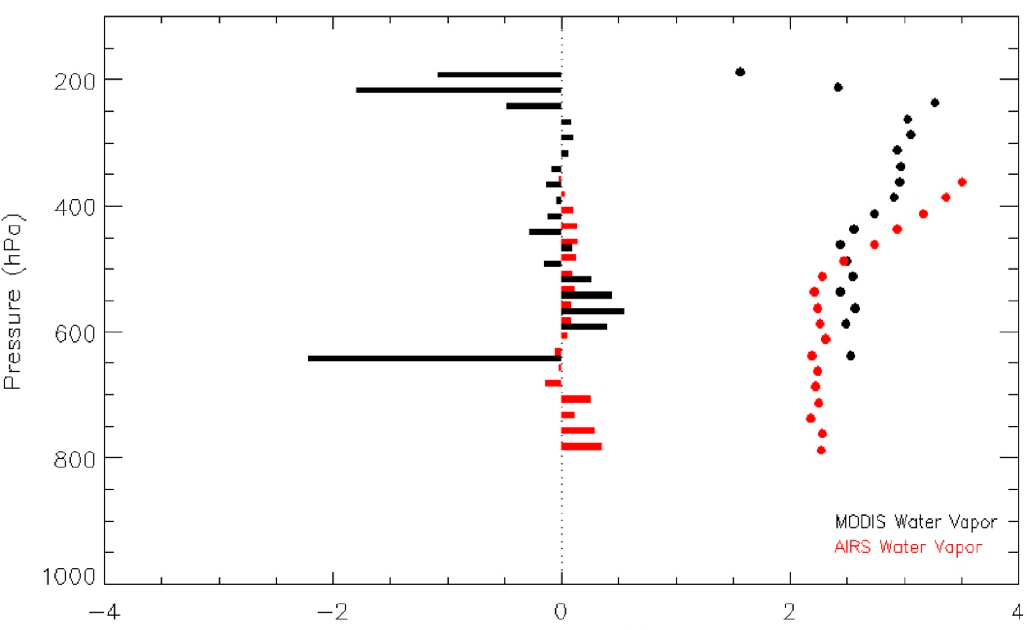
Figure 15. Mean (bars) and standard deviation (circles) of observation departures (m s − 1 ) (observed minus 6-hour forecasted wind) for MODIS (black) and AIRS (red) water vapor AMVs 0000 UTC 1 May 2015 to 1800 UTC 31 July 2015.